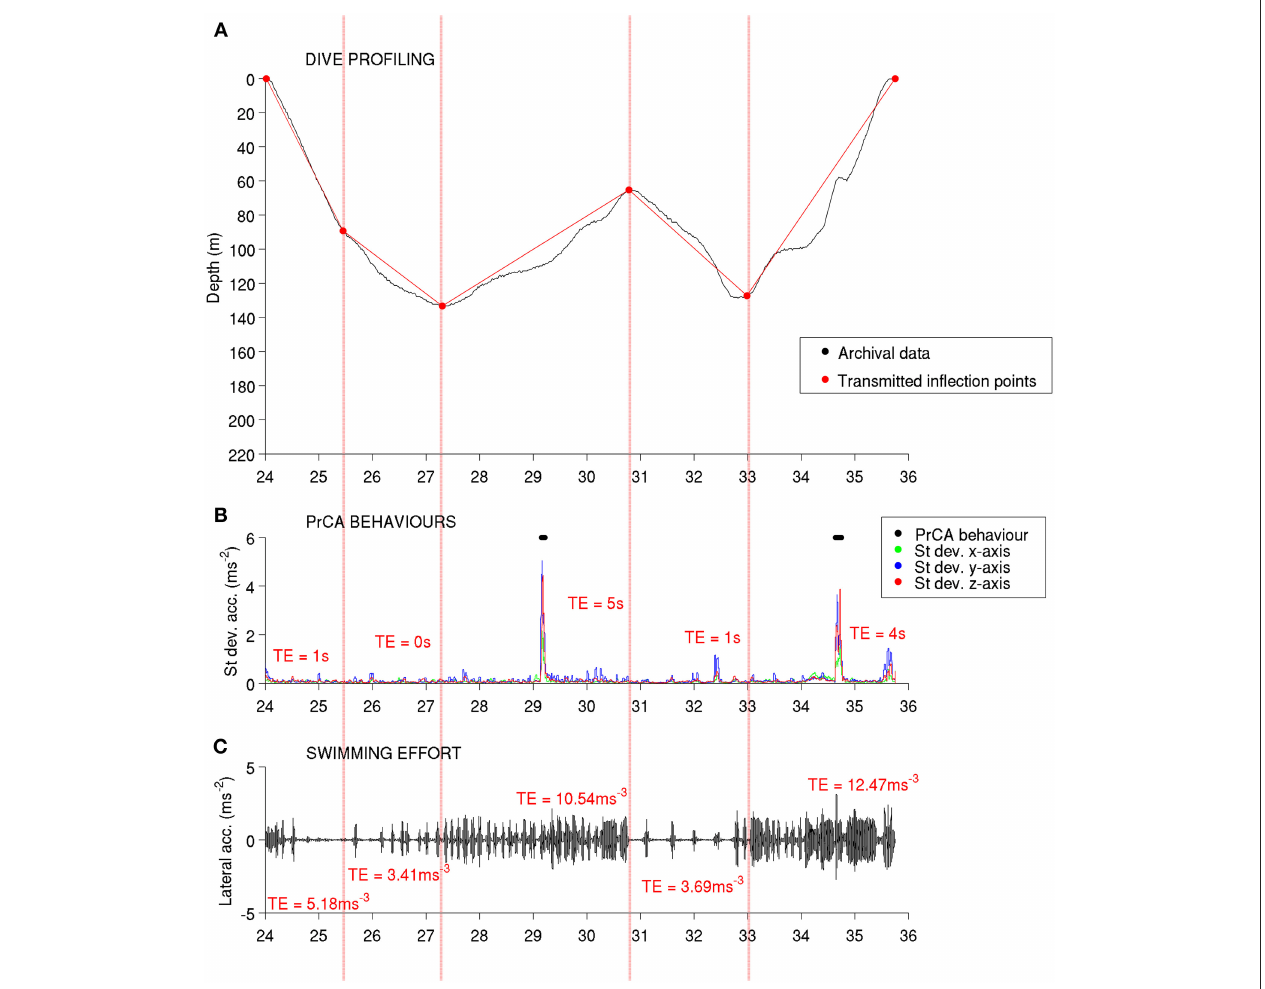
FIGURE 1 | Overview of the high-resolution archives (prior to summarizing) and associated DSA tag data transmissions from one example dive. Red dotted partitions from left to right correspond to each segment [1–5, respectively; identified via an on-board broken-stick algorithm (BS DSA )]. From top to bottom: (A) depth measurements from high-resolution archives in black and reconstructions from transmitted BS DSA inflection points in red, (B) standard deviations in acceleration from high-resolution archives along the three axes (green = x , blue = y and red = z ) with identified PrCA archival behaviors marked by black dots, and (C) filtered lateral (y) accelerations from high resolution archival data showing stroke amplitudes and rates (used to estimate swimming effort). Red text (B,C) corresponds to transmitted estimates (TE) for each segment.